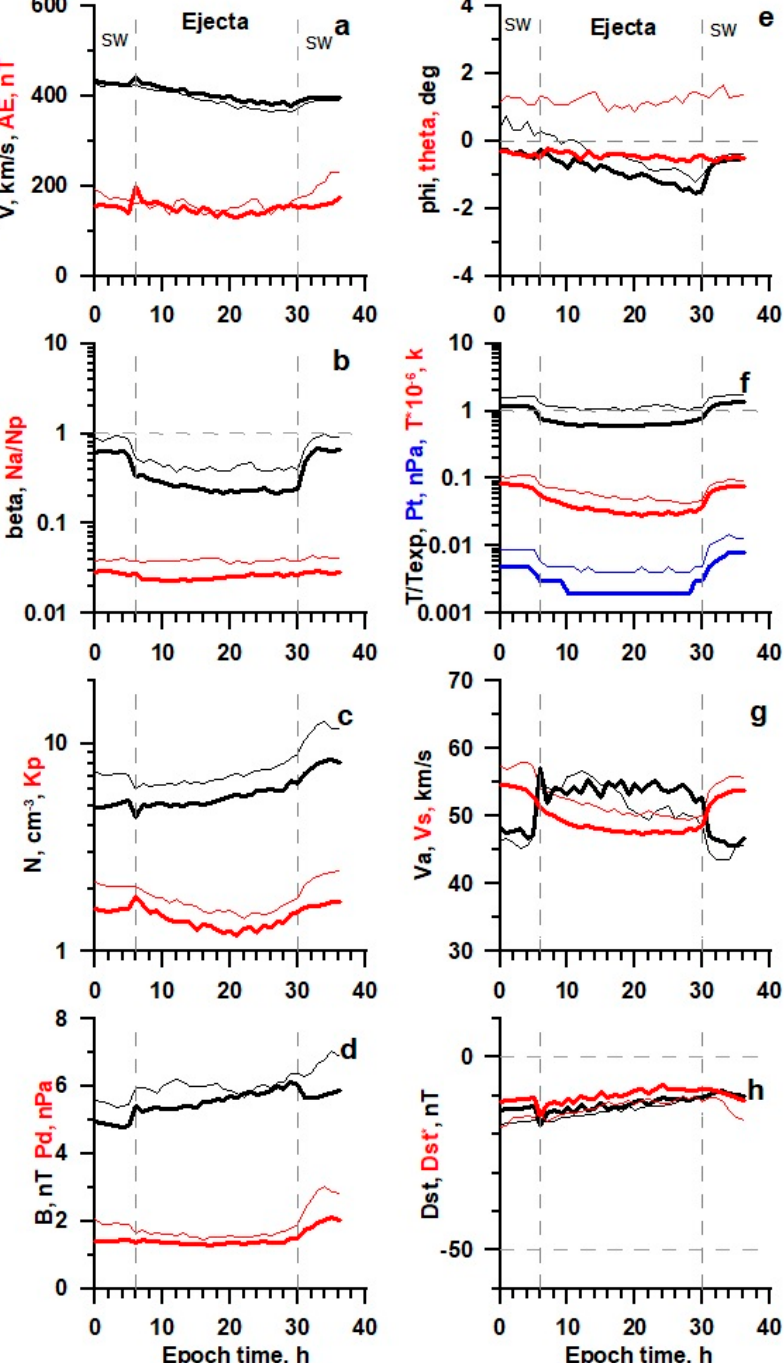
Figure 3. The temporal profile of solar wind and IMF parameters (see legend in the text) for Ejecta obtained by the double superposed epoch analysis for 287 events in 21–22 SCs (thin lines) and 491 events in 23–24 SCs (thick lines).